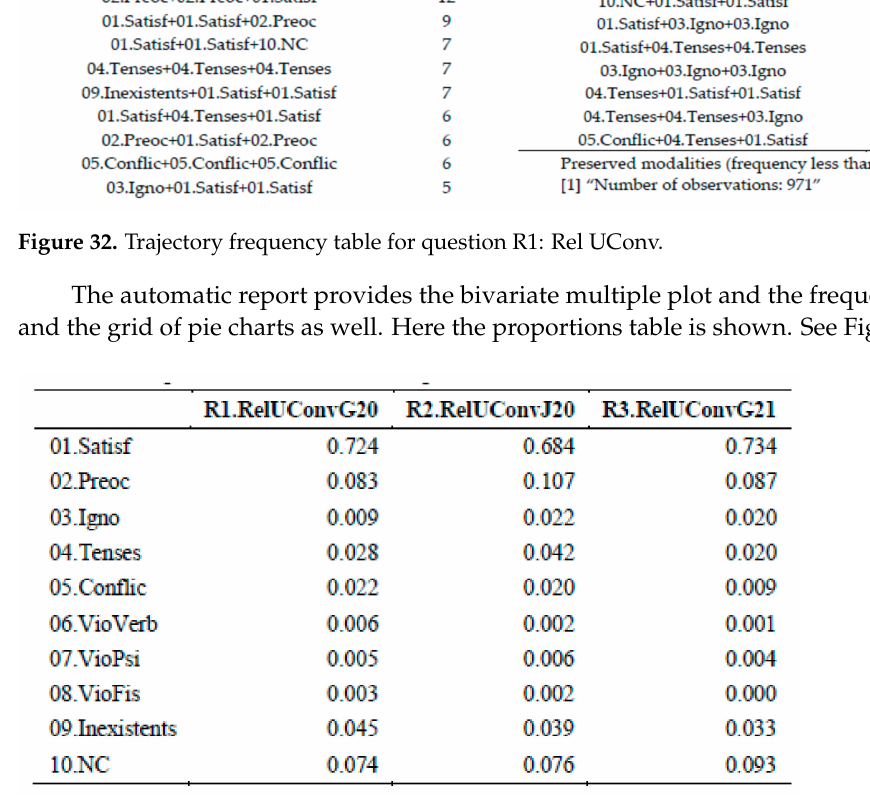
Figure 33. Proportions of R1.RelUConv per